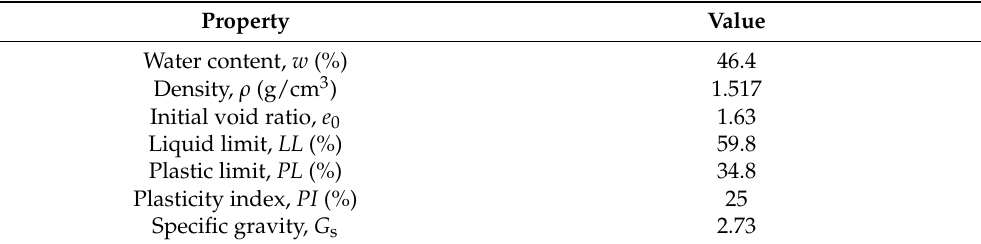
Table 1. Basic properties of soil samples.